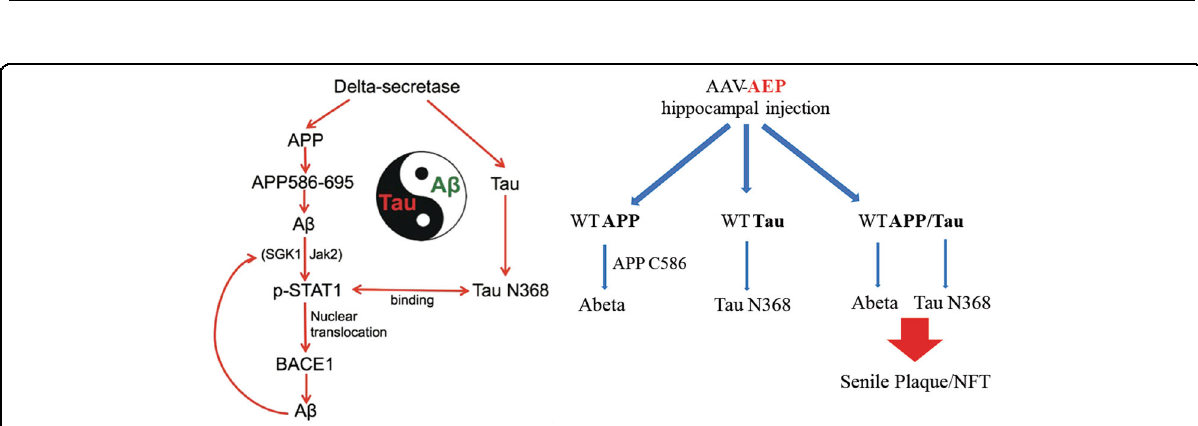
Fig. 1 Active δ -secretase triggers AD pathologies by cleaving both Tau and APP. The schematic model demonstrates that AEP ( δ -secretase) is activated in an age-dependent manner and cleaves APP at N585 and Tau at N368, which triggers AD pathology.